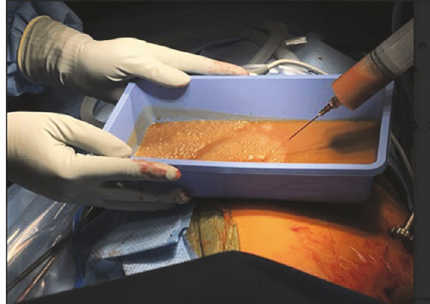
Figure 4: Brown murky fluid aspirated from the pericardial